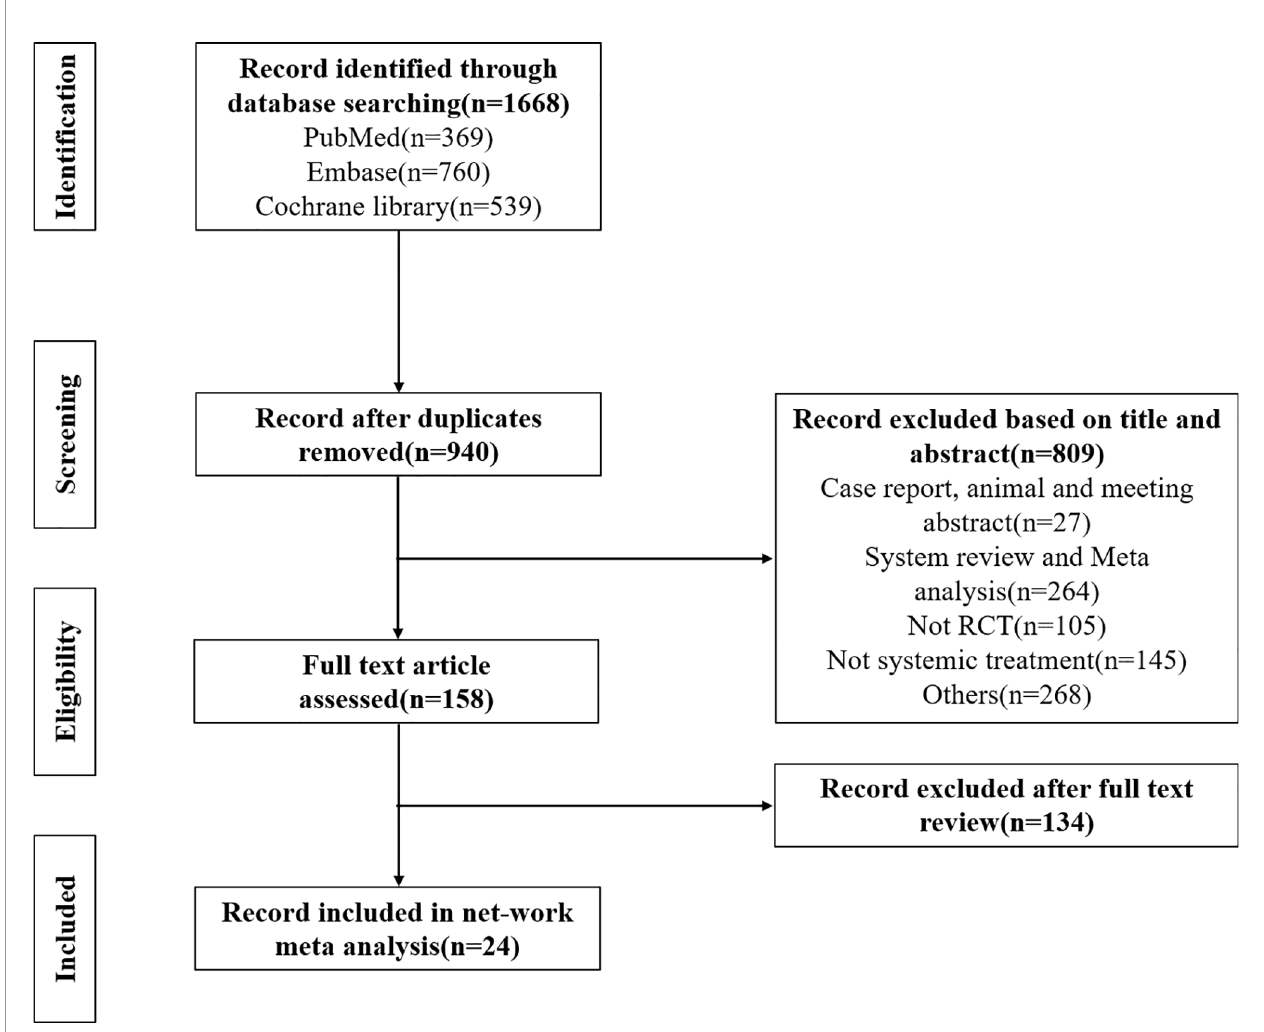
FIGURE 1 | Literature search, screening process, and results